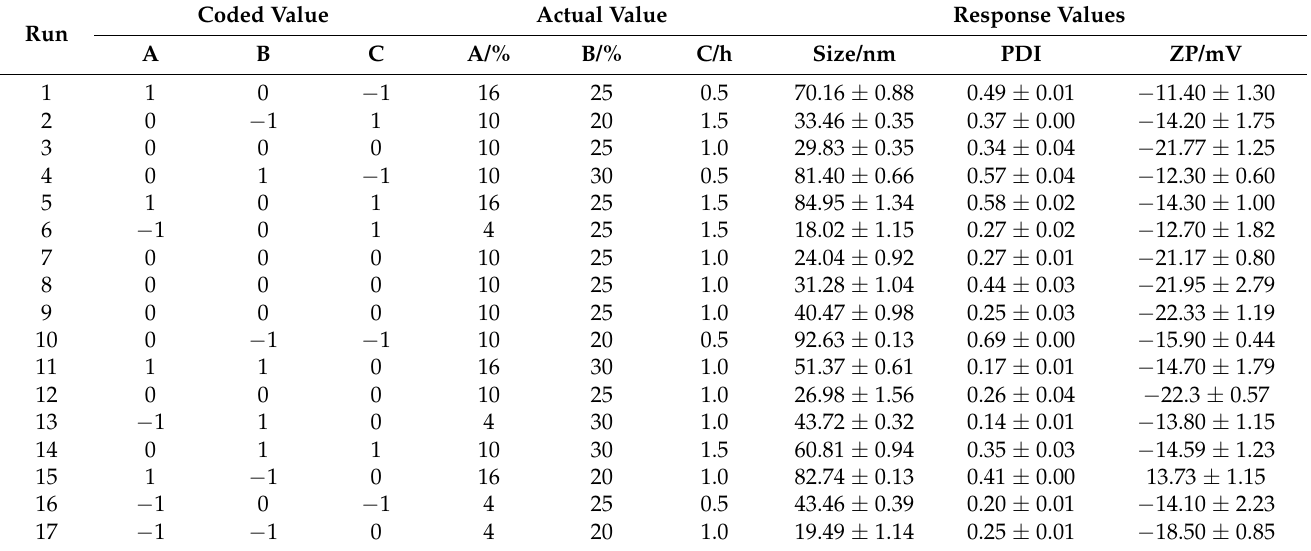
Table 1. Experimental trials, independent variables and observed response for Box–Behnken design used for preparation of VOC-NE. ( n = 3, X ±